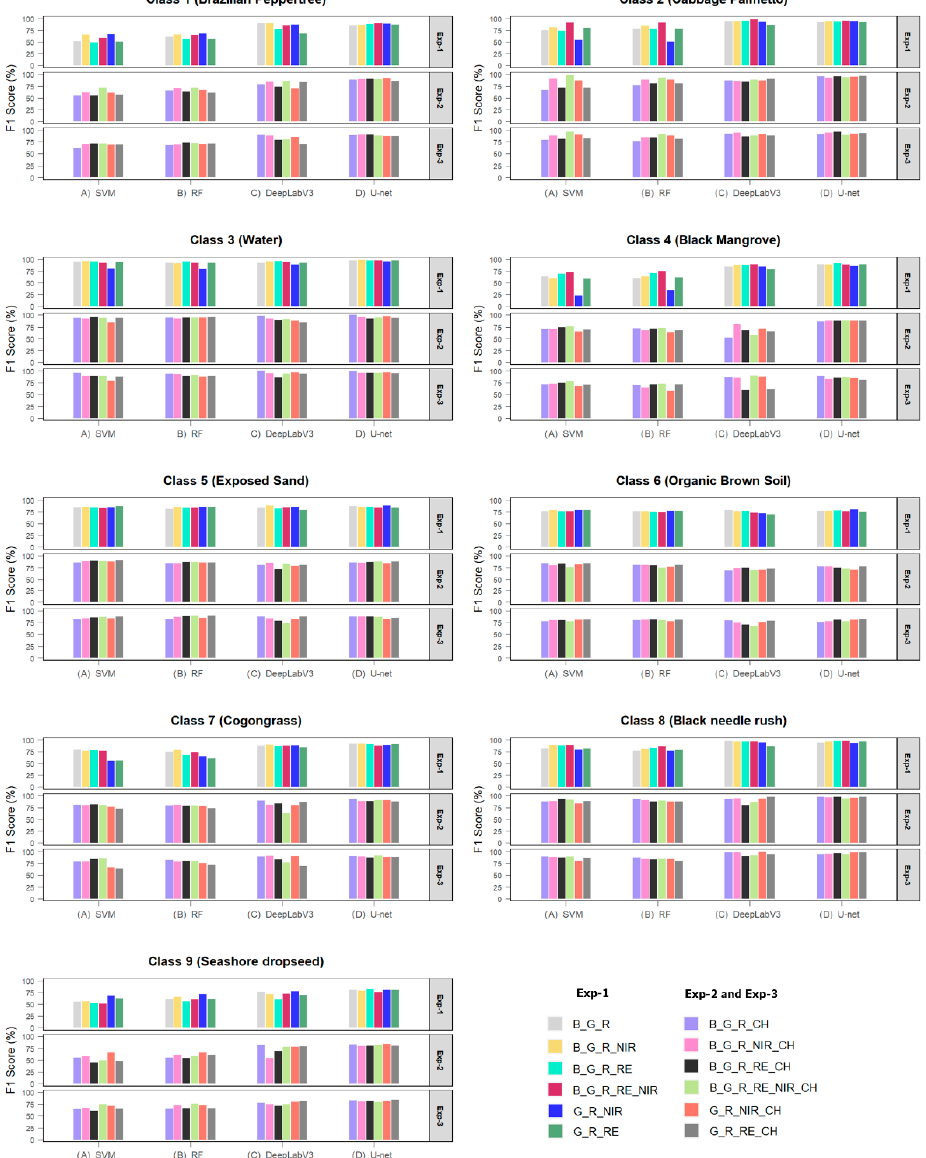
Figure 13. F1 scores organized by experiment, classification method, and band combination, classes 1 to